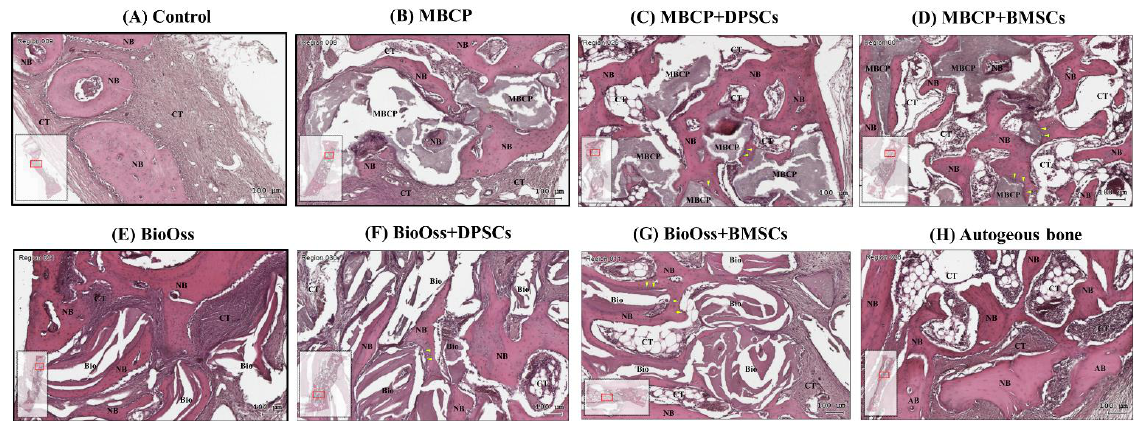
Figure 7. Histological analysis of calvarial bone defects after 4 weeks of healing in ( A ) the empty control, ( B ) MBCP, ( C ) MBCP+DPSCs, ( D ) MBCP+BMSCs, ( E ) Bio-Oss, ( F ) Bio-Oss+DPSCs, ( G ) Bio-Oss+BMSCs, and ( H ) autogenous bone groups. NB = new bone, CT = connective tissue, MBCP = MBCP, Bio = Bio-Oss, and AB = autogenous bone. Scale bar = 100 μm.